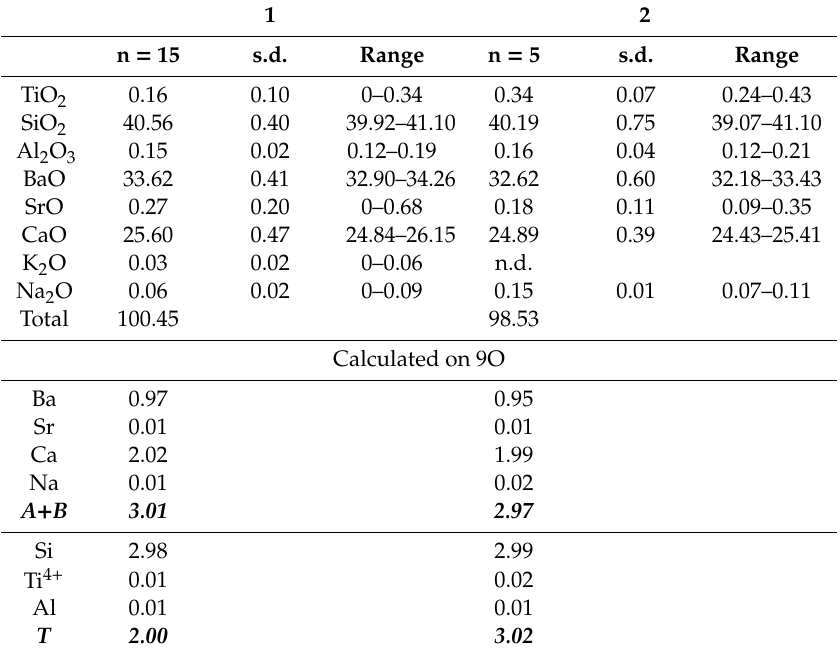
Table 5. Chemical composition of walstromite from Gurim Anticline (1) and Zuk Tamrur (2), wt.%. 1 2 n = 15